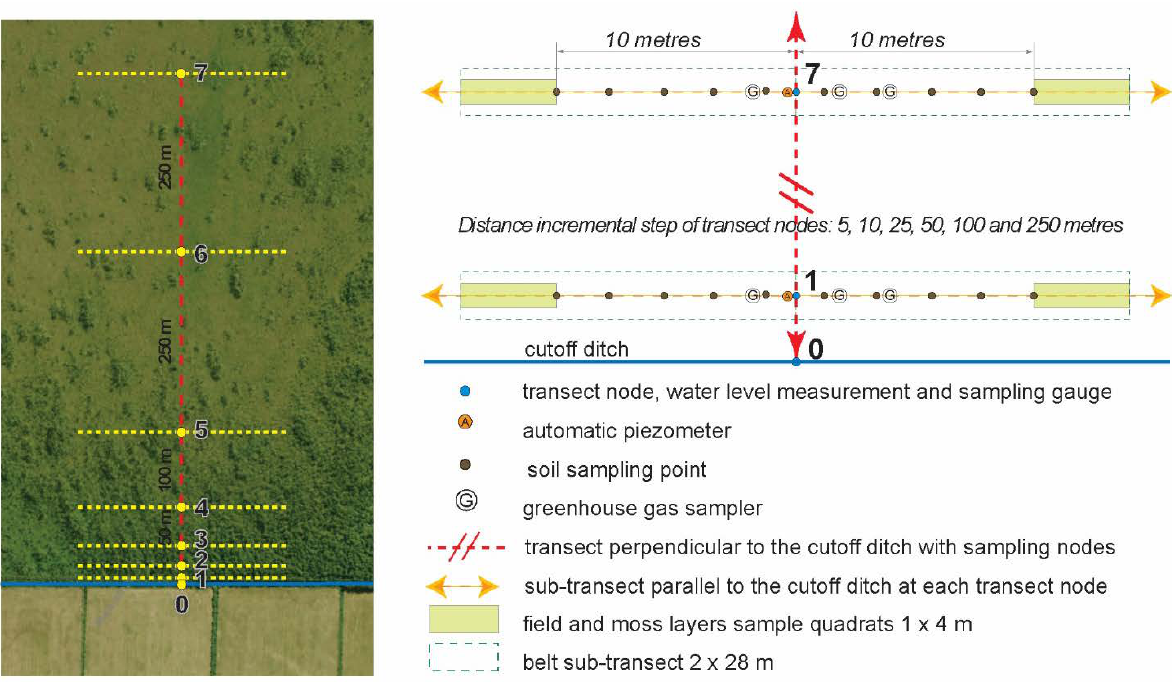
Figure 2. Study transect and layout of sampling areas with nodes and sampling plots along the